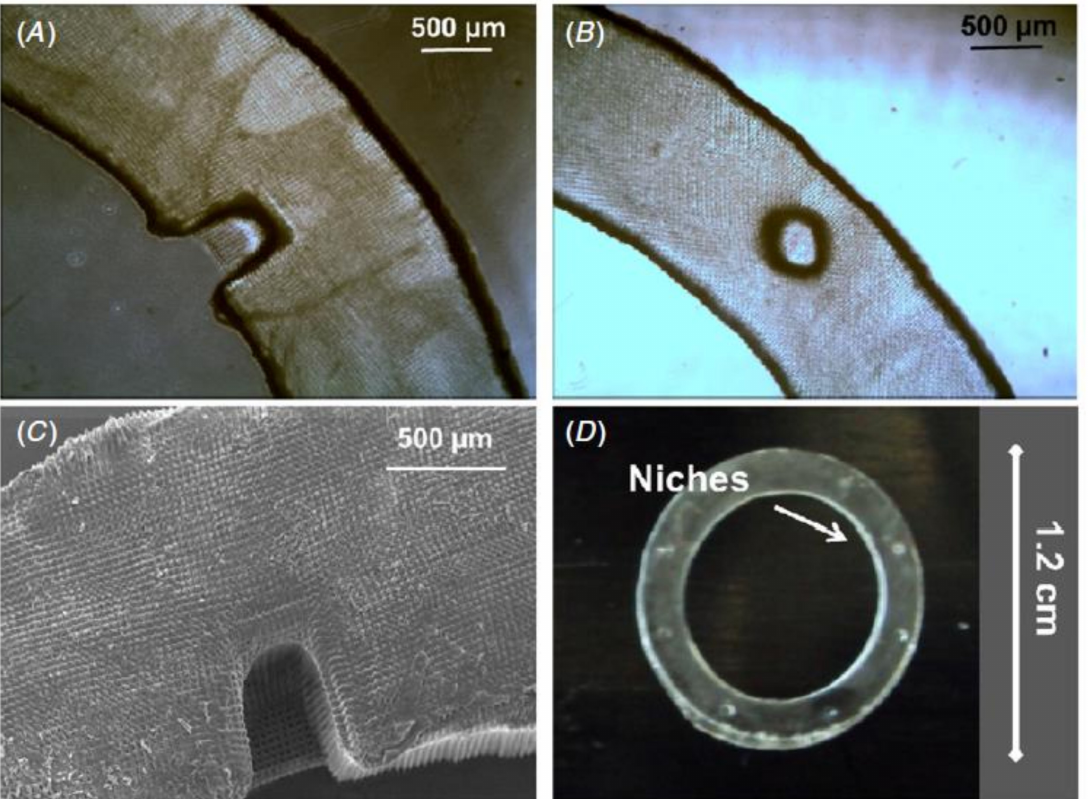
Figure 10. Phase contrast microscopy and scanning electron microscopy were used to investigate the structure of the PEGDA rings. ( A ) Describes the optical micrographs of the PEGDA outer ring with horseshoe morphology. ( B ) Describes the circular morphology of the micrographs of PEGDA. ( C ) Describes a SEM micrography of the PEGDA outer ring with horseshoe niches. ( D ) Shows a PEGDA outer ring of diameter 1.2 cm with well-defined artificial micro-pockets of diameter around 300 µ m